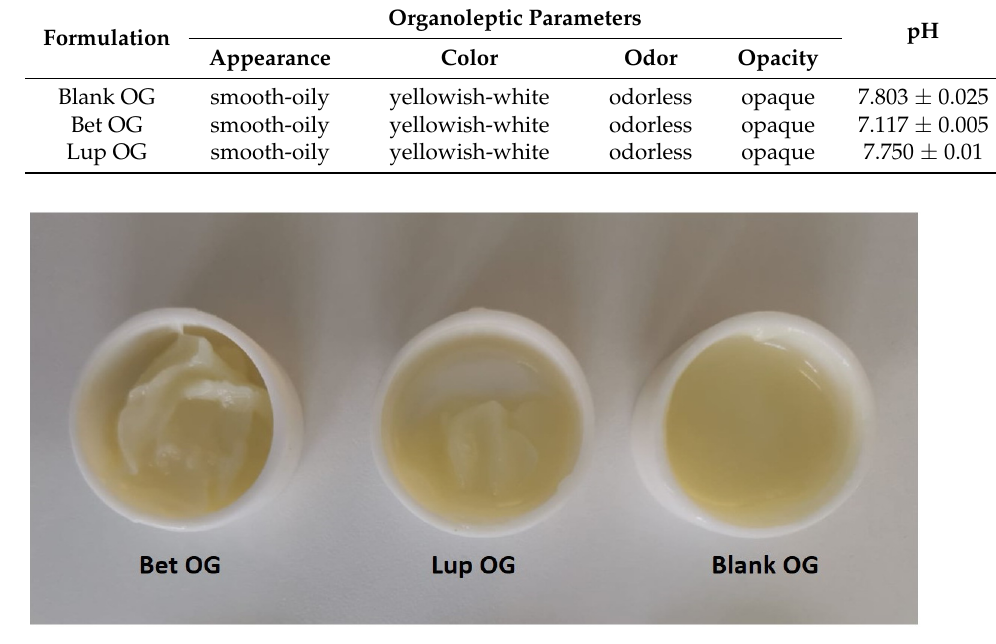
Figure 1. The appearance of the three oleogels.